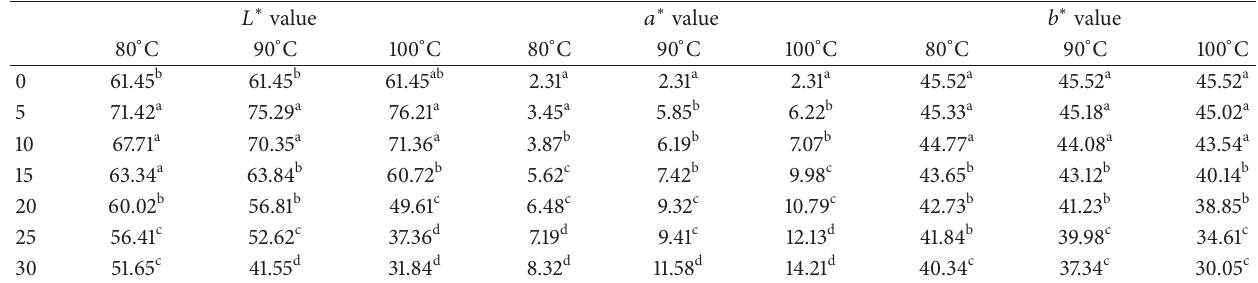
Table 2: Color values of jackfruit chips at different frying